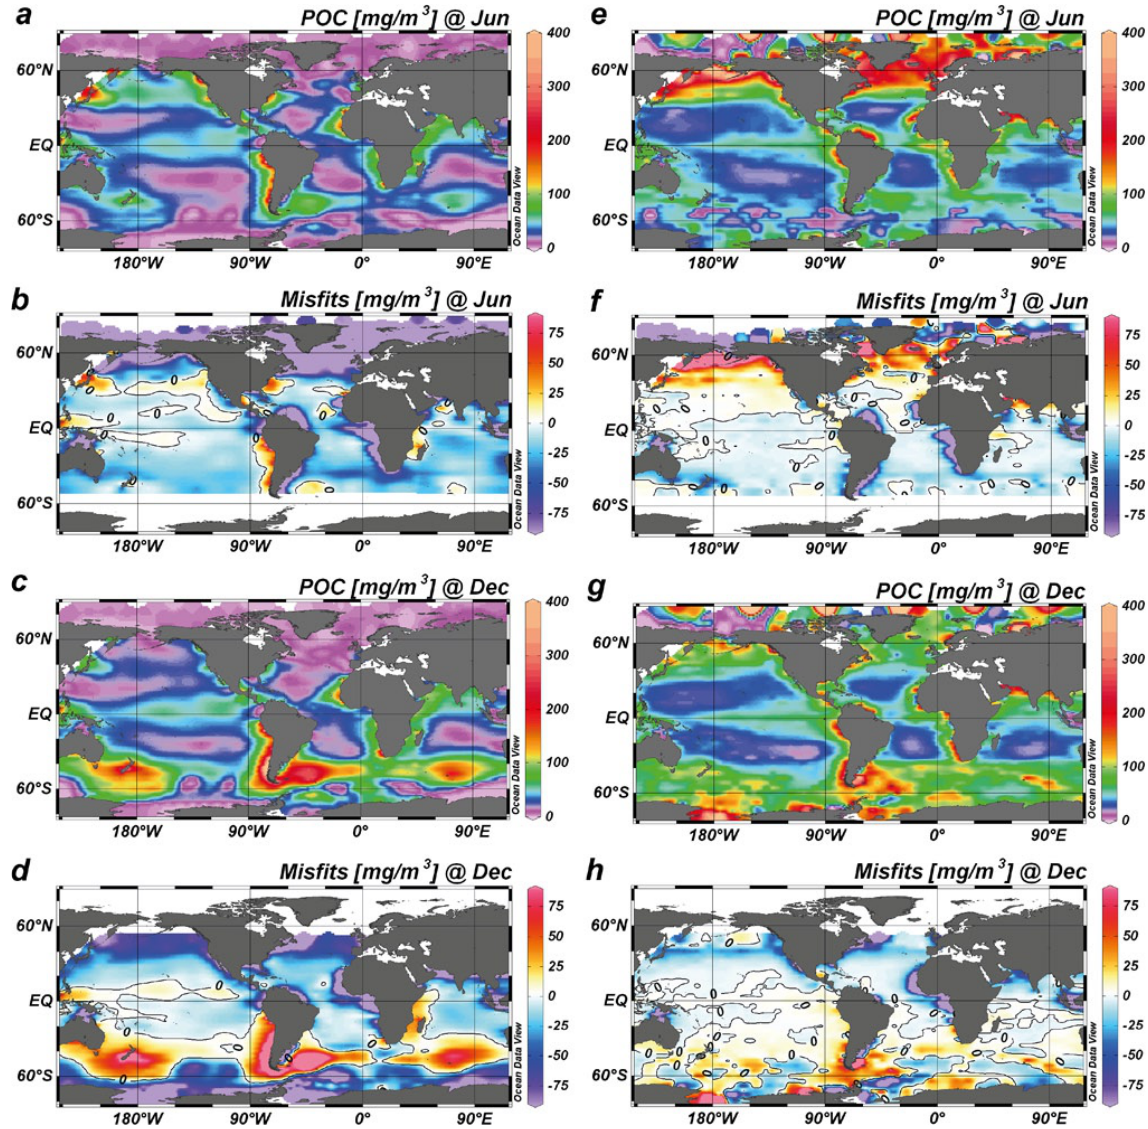
Fig. 8. Model-simulated surface water POC and model–data misfits for June and December. The left-hand column (a–d) is for Exp A, and the right-hand column (e–h) for Exp